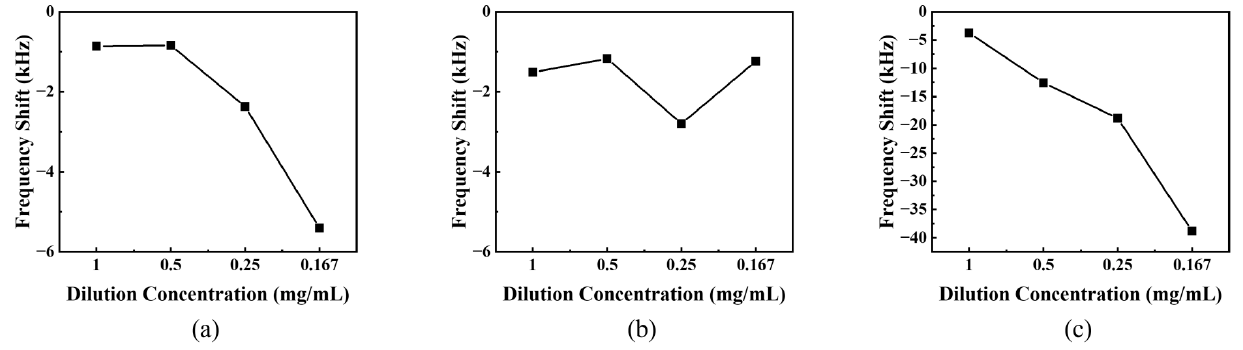
Figure 7. Maximum frequency shift according to DMMP response from SAW sensor according to coating concentration of sensing material: ( a ) PSS-TU1, ( b ) PSS-TU2, ( c ) PSS-TU3.